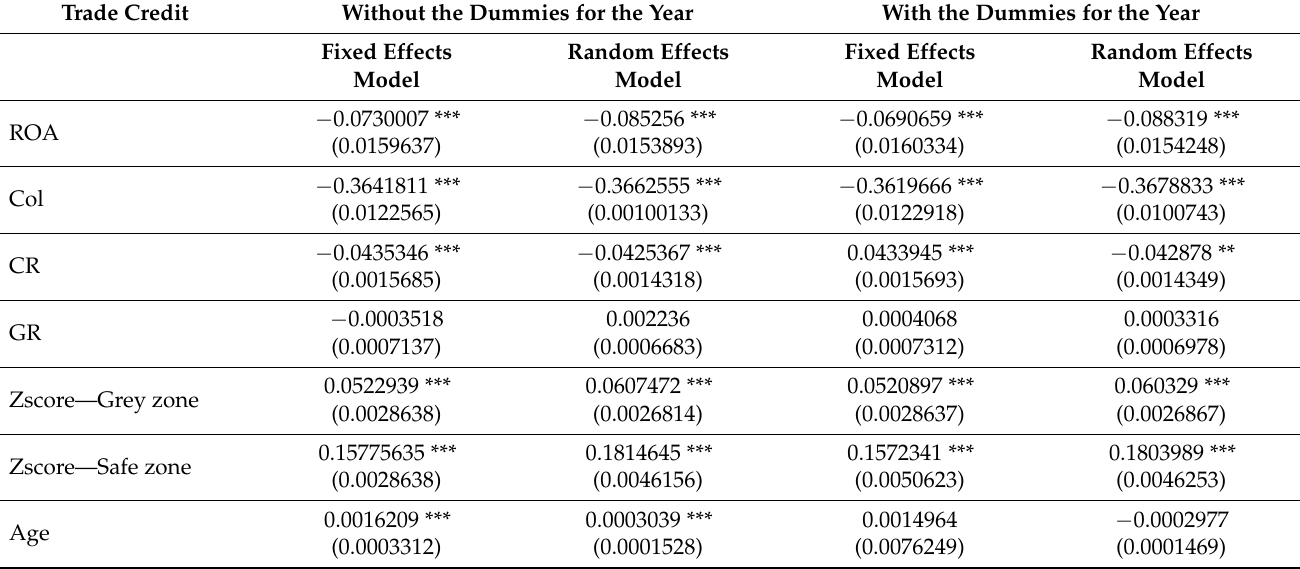
Table 4. Estimated models for trade